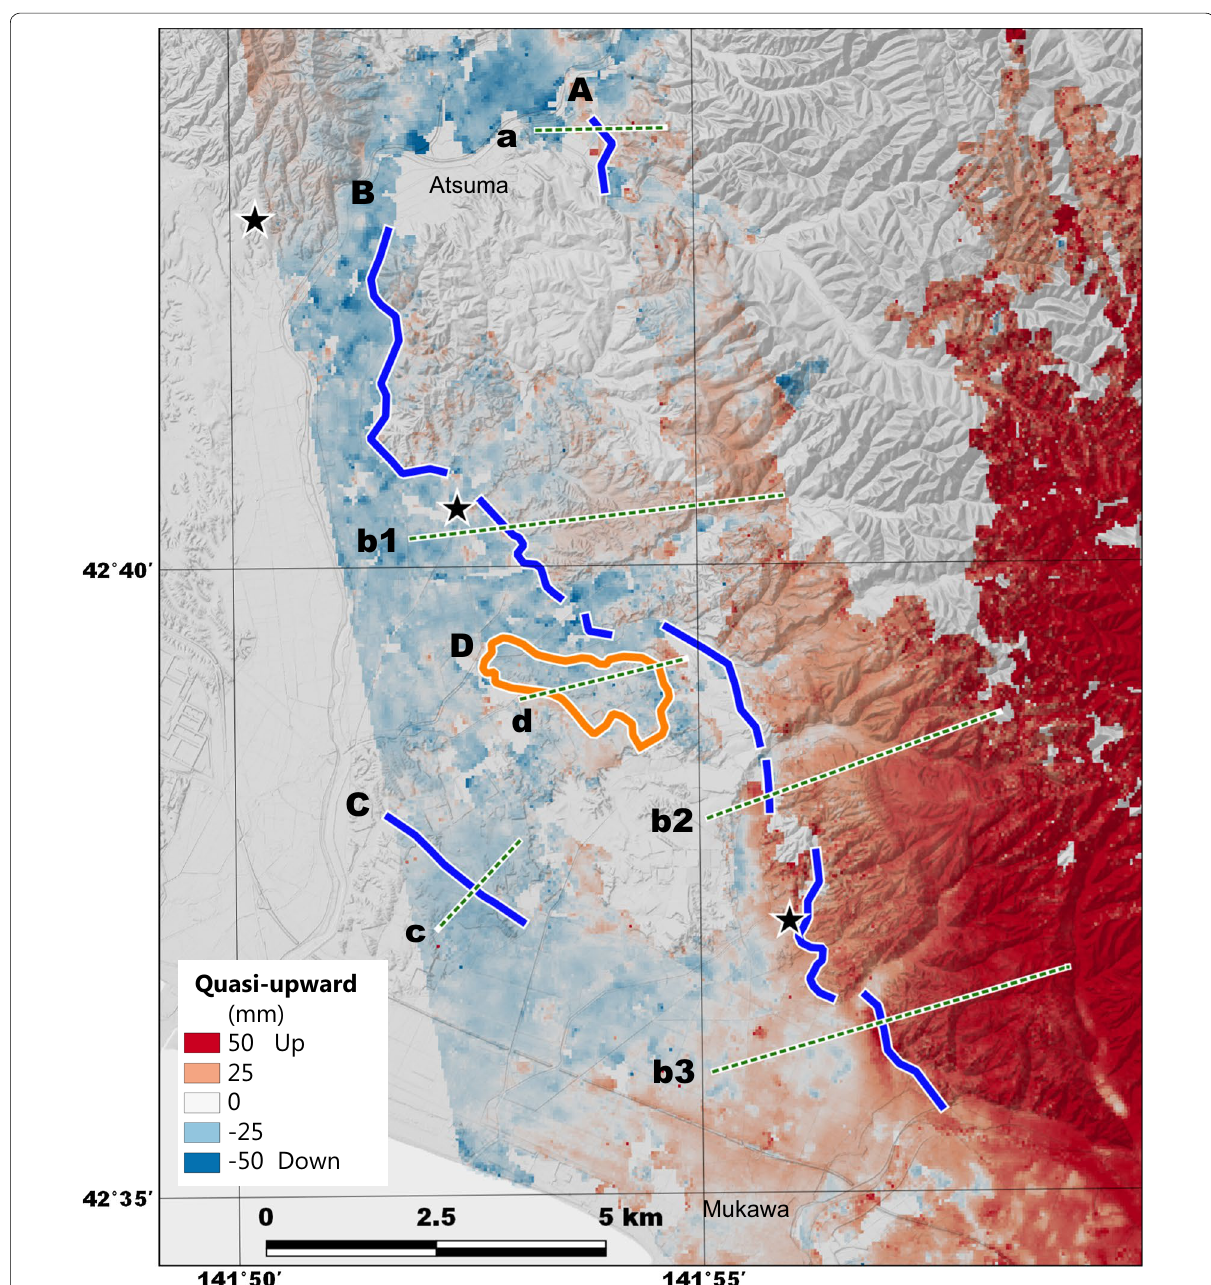
Fig. 5 Displacement map (2.5-D) for quasi-upward direction synthesized from the SAR interferograms in Figs. 2 and 4. Blue lines (A, B, and C) show the linear surface displacements. The orange line (D) shows an independent surface displacement with a rounded pattern. Dashed lines (a, b1–3, c, and d) mark the cross sections shown in Fig. 7. Black stars indicate the positions of discontinuities in the basement identified by seismic exploration (Yokokura et al.